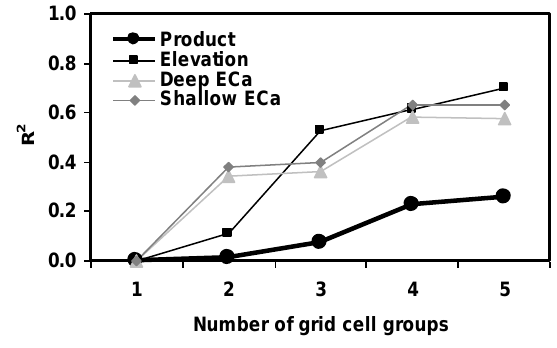
Figure 3. Change in R 2 product with number of delineated grid cell